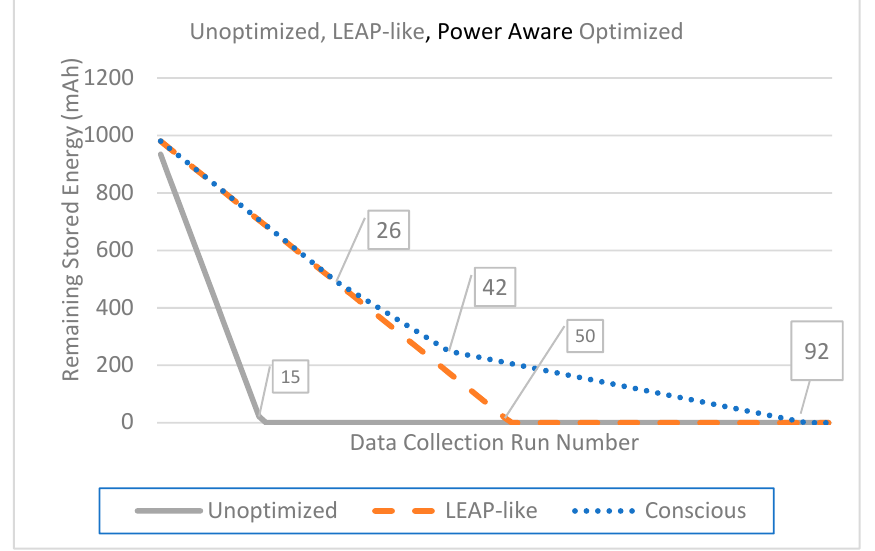
Figure 4. Power aware optimization runs the most data collection cycles [16].